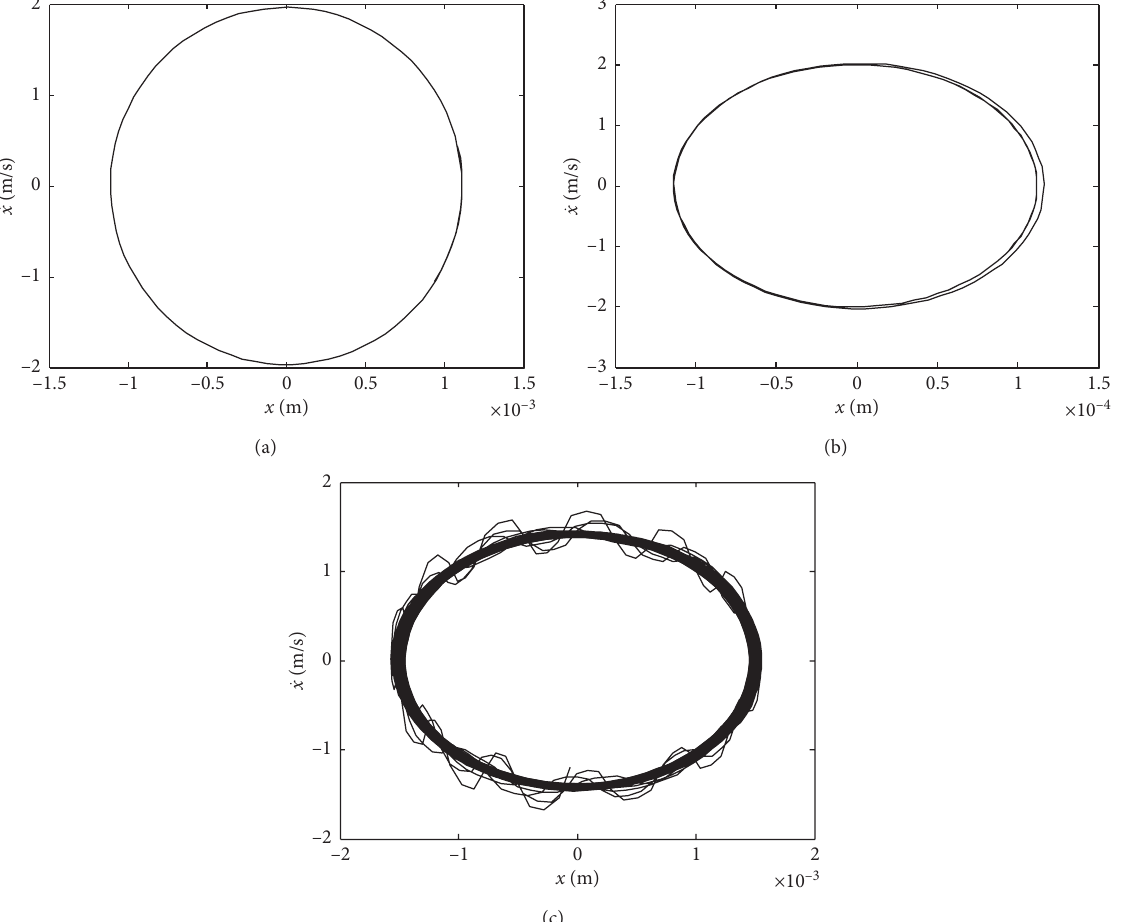
Figure 14: Phase paths of horizontal vibration of the rolling mill rolls under varying external excitation amplitude: (a) F F 0 � 5.95 e 5N, and (c) F 0 � 6.20 e